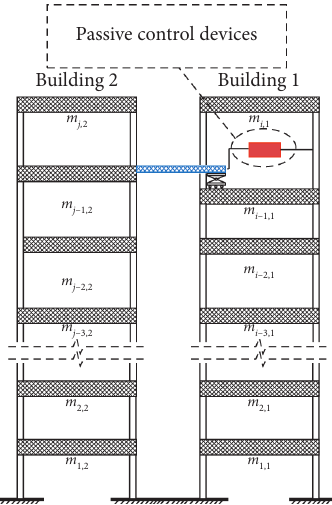
Figure 1: The structural sketch of the two adjacent high-rise